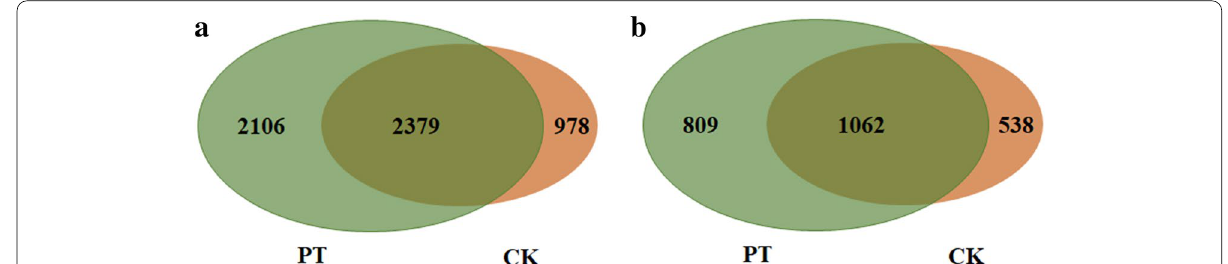
Fig. 3 Venn diagrams of unique and shared OTUs between the CK- and PT-treated rhizosphere soils based on 16S and ITS high-throughput sequencing results ( a bacterial OTUs, b fungal